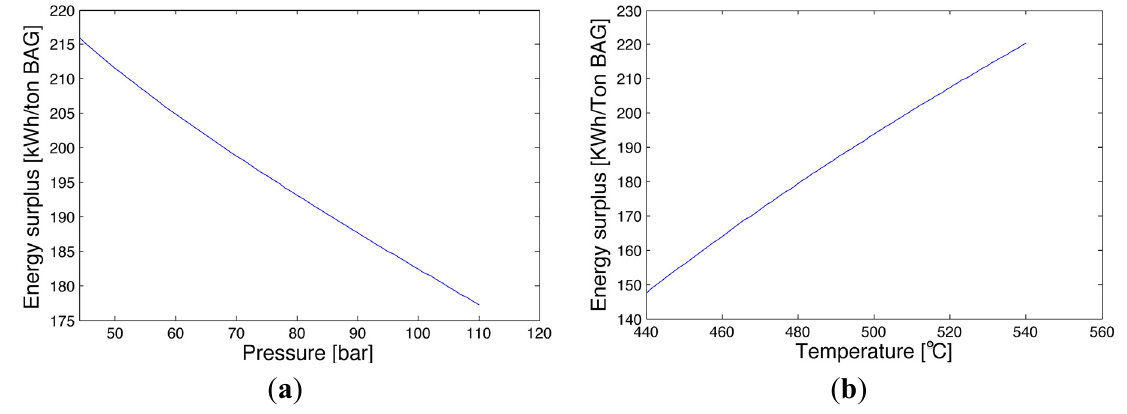
Figure 11. Effect of new cycle boiler’s pressure and temperature on energy surplus index in Option 1 repowering. (a) Pressure; (b) Temperature.